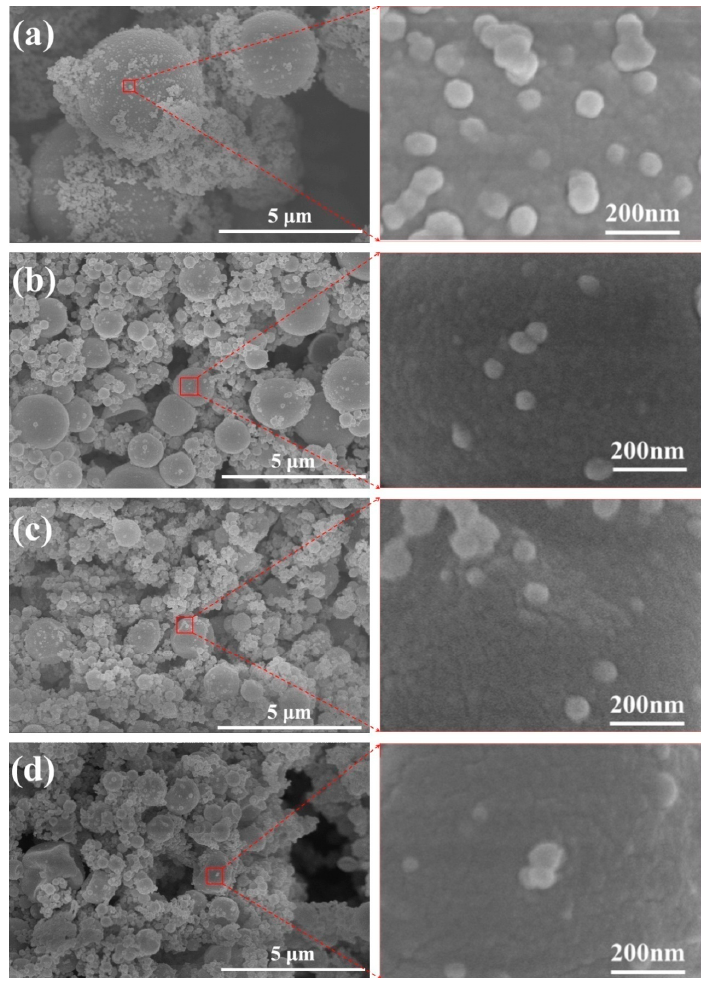
Figure 2. SEM micrographs of Micro/NanoPCMs containing various core materials fabricated with SMA concentration of 10 wt %: ( a ) MicroH; ( b ) MicroEH; ( c ) MicroHA; and ( d ) MicroPHA.